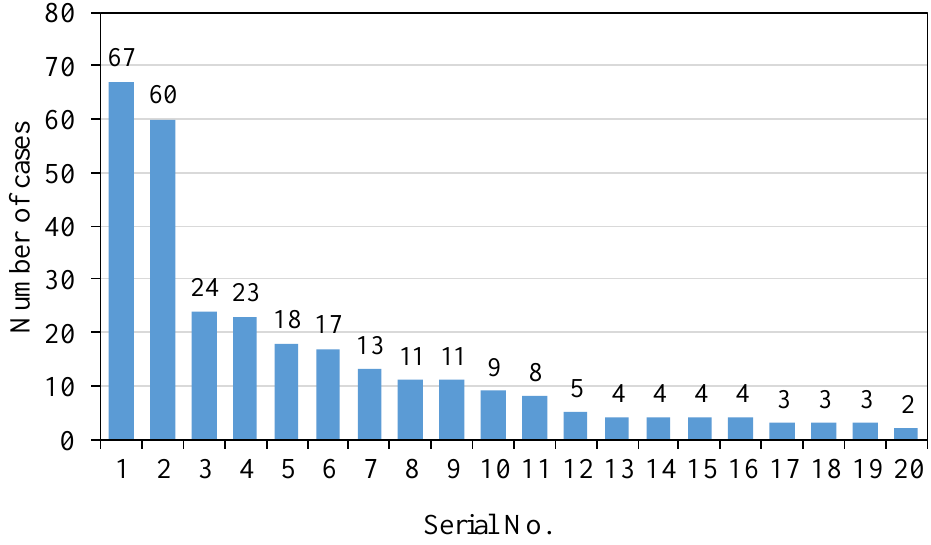
Figure 2. Frequency map of toponymic elements (Serial No. 1–20 represent family name, orientation, keng (pit), plant, event, animal, ping (flat), shan (mountain), wu (dock), ling (ridge), yan (rock), yang (sun), pai (row), fan (farmland), pong (clump), tan (beach), gang (hillock), tian (paddy field), ling (ridge), ao (depression), respectively).